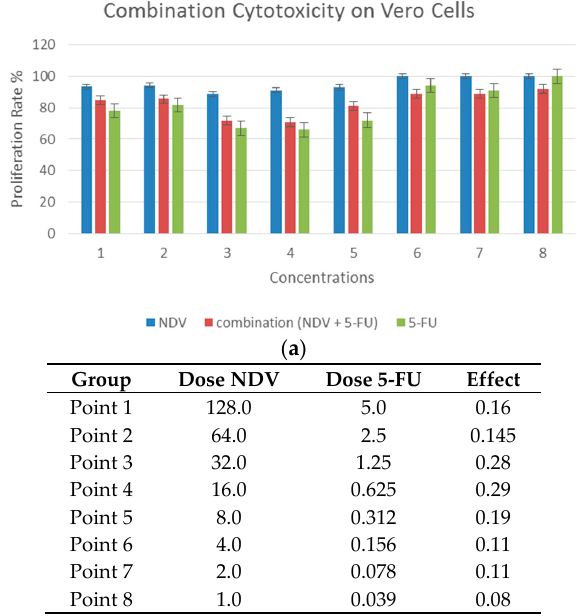
Figure 4. Combination cytotoxicity on Monkey kidney Vero cells. ( a ) The cytotoxic effect of 5-FU, NDV, or both, on cell proliferation. The cells were treated with 5-FU (5 µg in two-fold serial dilutions up to 0.039 µg/mL), NDV (128 HUA with two-fold serial dilutions) or a combination of the two. The results for the treated groups are expressed as the cell proliferation rate compared with untreated control cells grown under identical conditions. Most of the concentrations used alone or in combination treatment lacked significant differences; and ( b ) table summarizing the combination data for each dose of combination points.